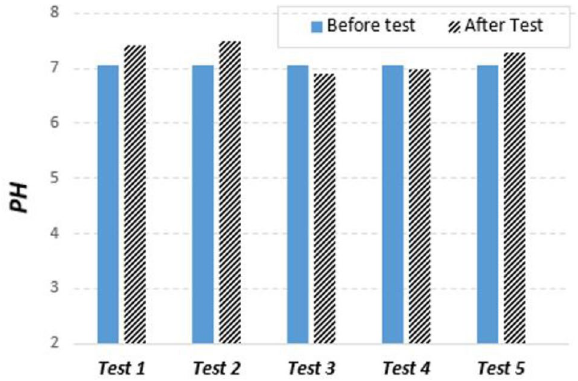
Fig. 7 Oil recovery (% IOIP) versus time resulted from spontaneous imbibition tests using reservoir carbonate cores [20] and sandstone in absence of connate water saturation. Left picture ( a ) is presented